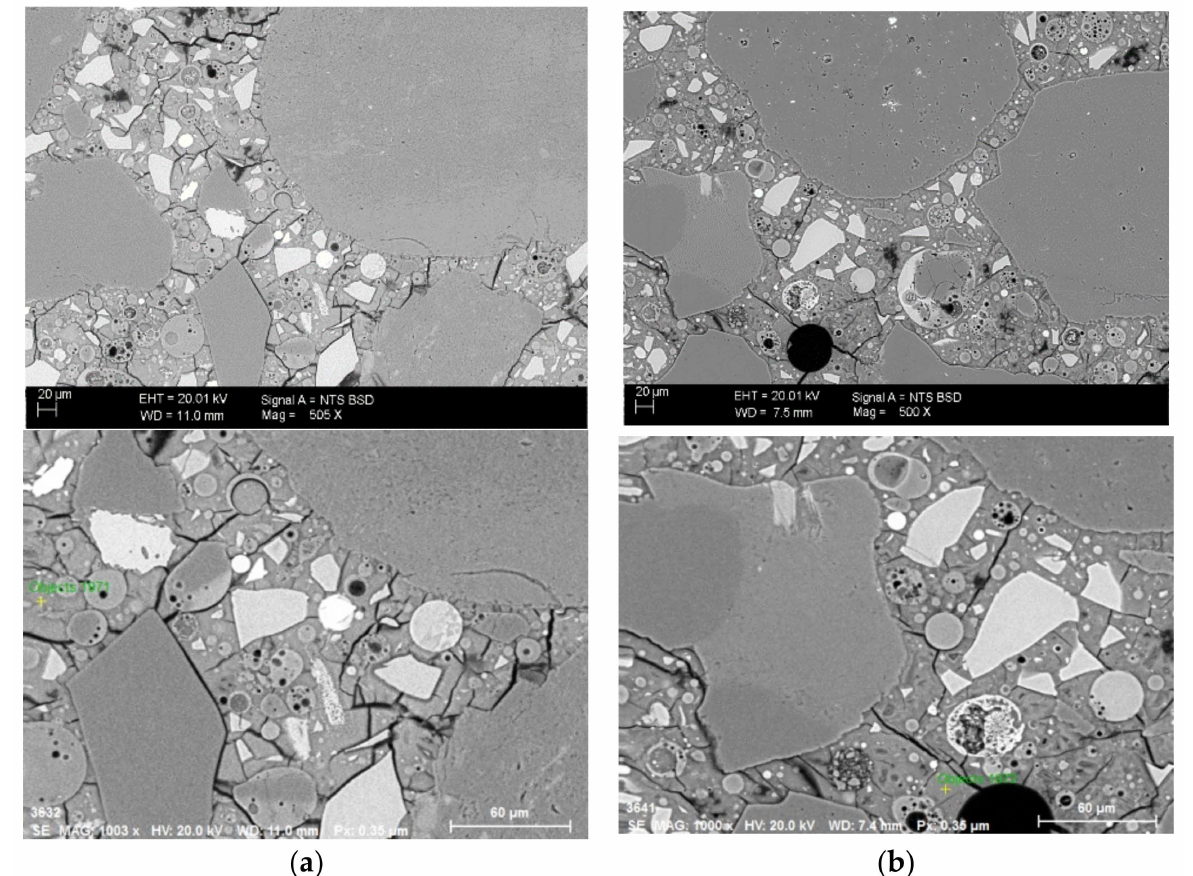
Figure 3. SEM images of geopolymer mortars ( a ) M50-K and ( b )